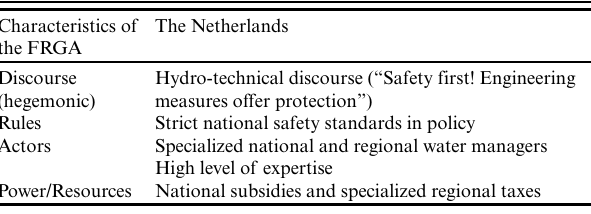
Table 3 . Characteristics of the Dutch flood risk governance arrangement (FRGA) before the flood event of